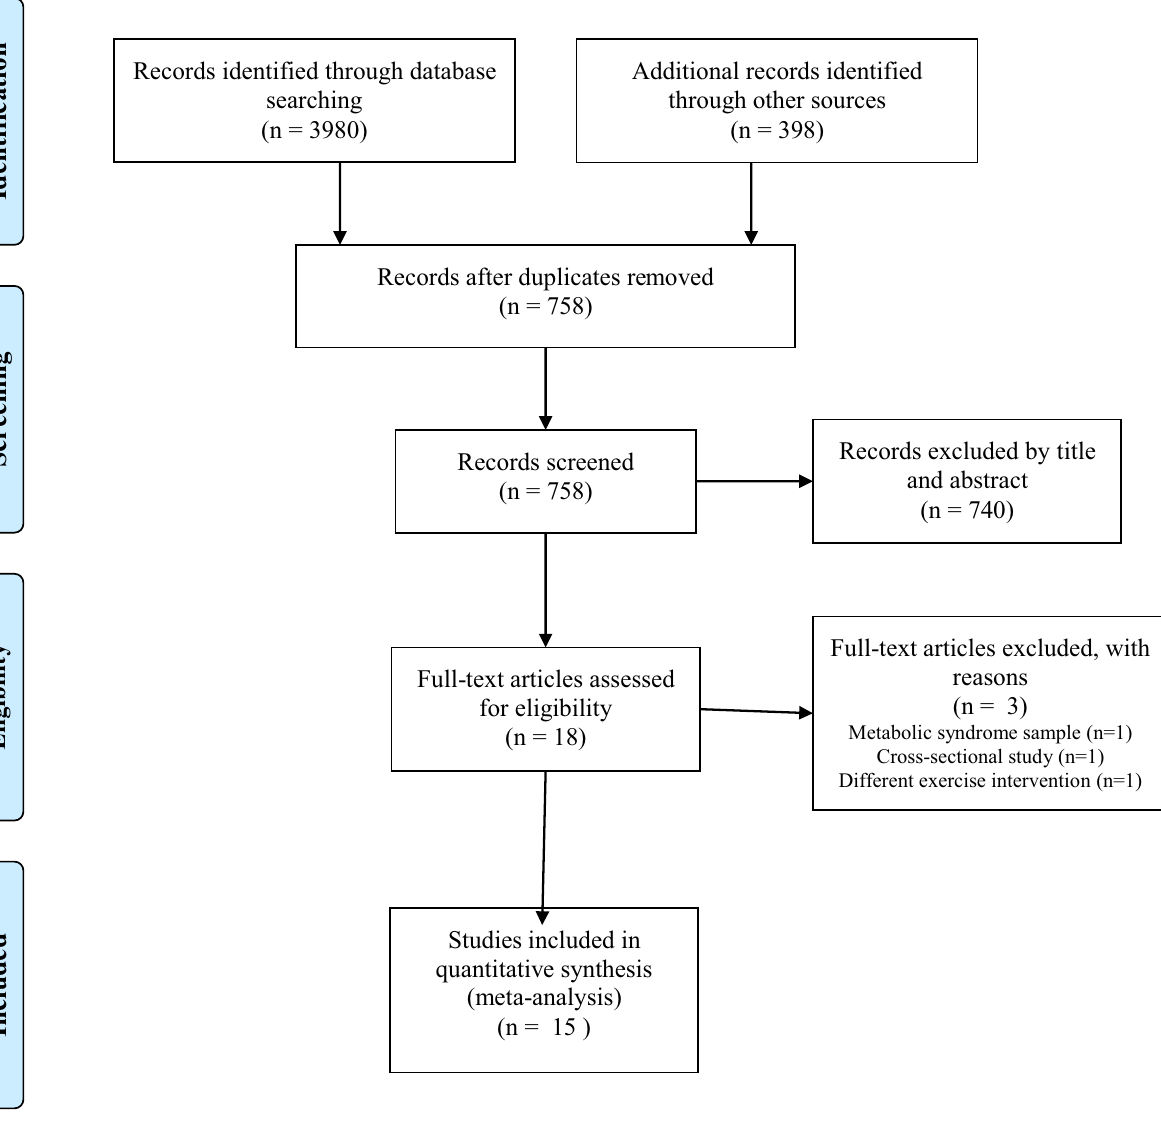
Figure 1. Flow diagram depicting the search